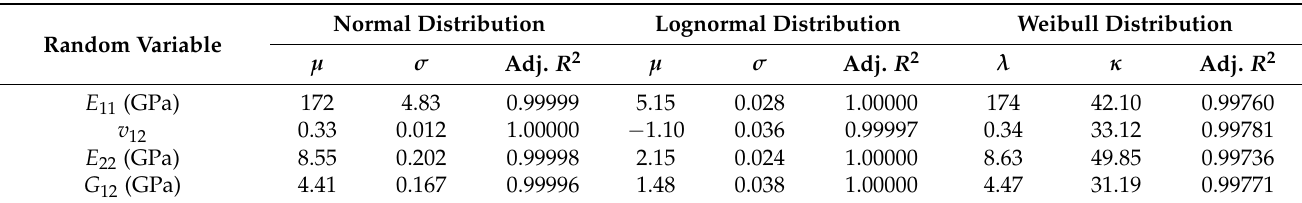
Table 3. Statistical models of the elastic properties of the T800/X850